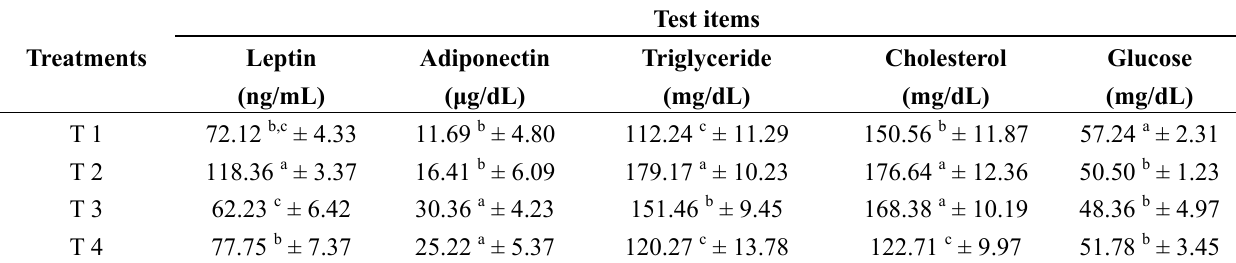
Table 1. Effect of binding of conjugated linoleic acid with biopolymers on blood characteristics in mice fed high- and low-fat